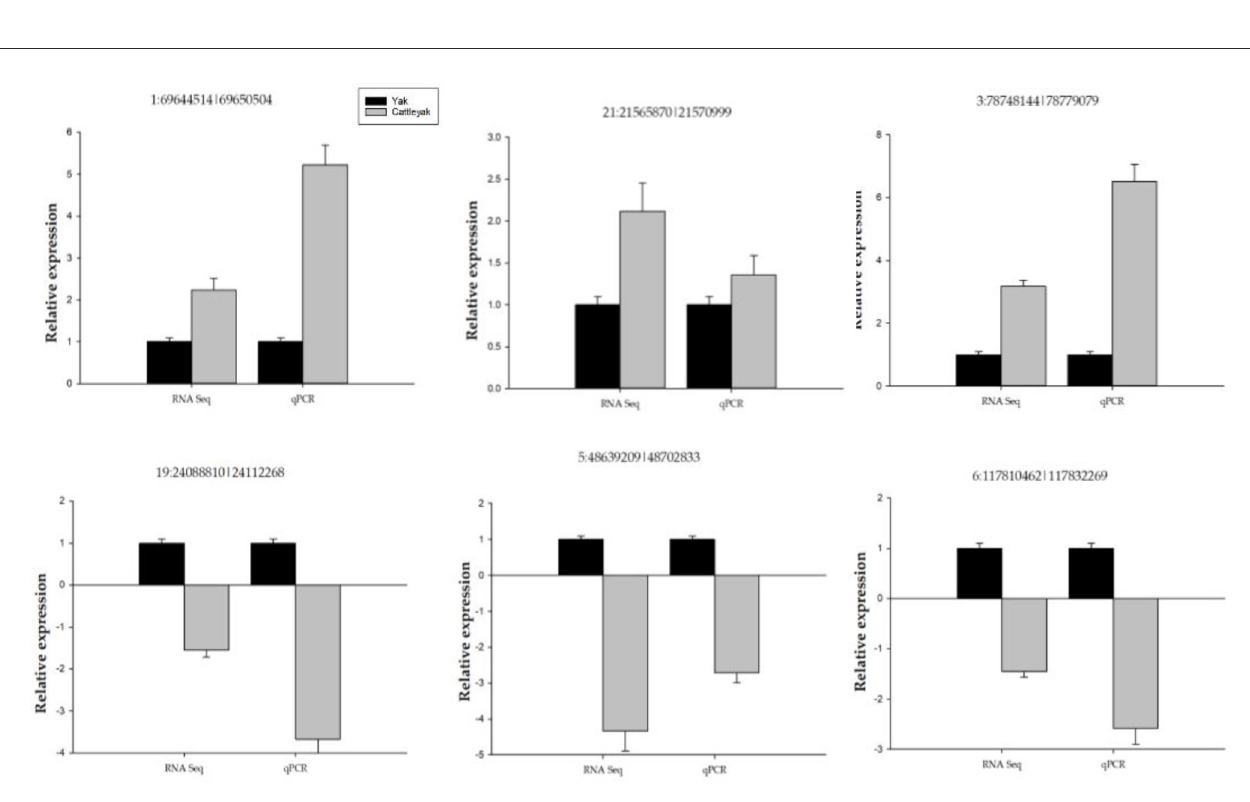
FIGURE10 Shows qPCR validation of some selected DE circRNAs. The y-axis indicates the relative expression of six DE circRNAs between yaks and